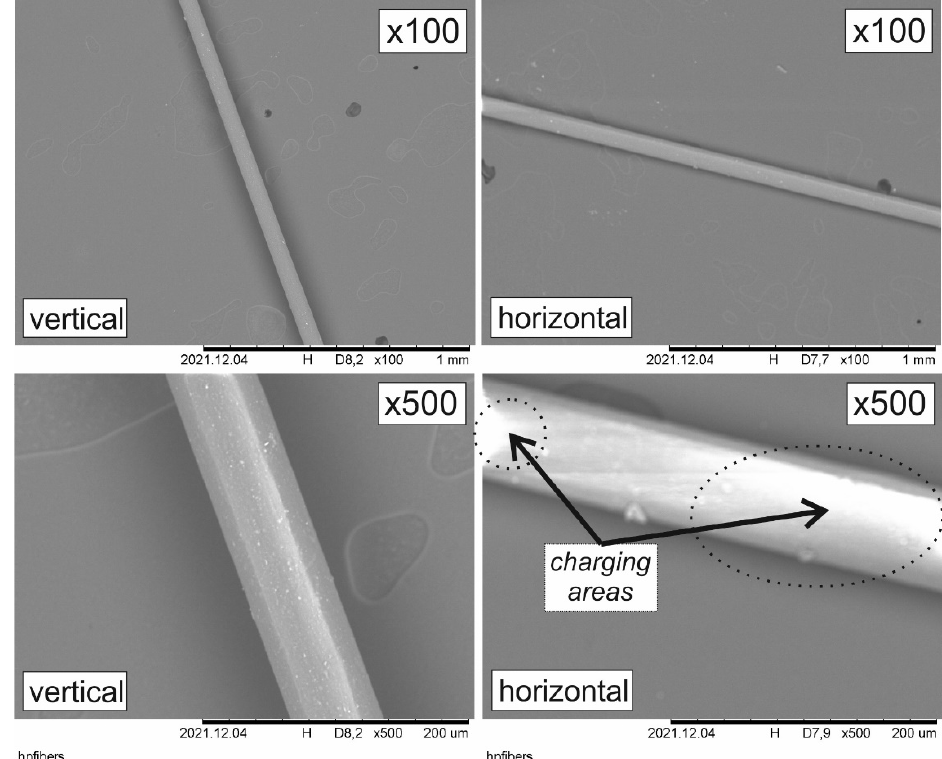
Figure 1. SEM images of a polyester filament fiber. The SEM images are recorded with two different magnifications (X100 or X500) and with two different fiber arrangements on the sample holder (horizontal or vertical).